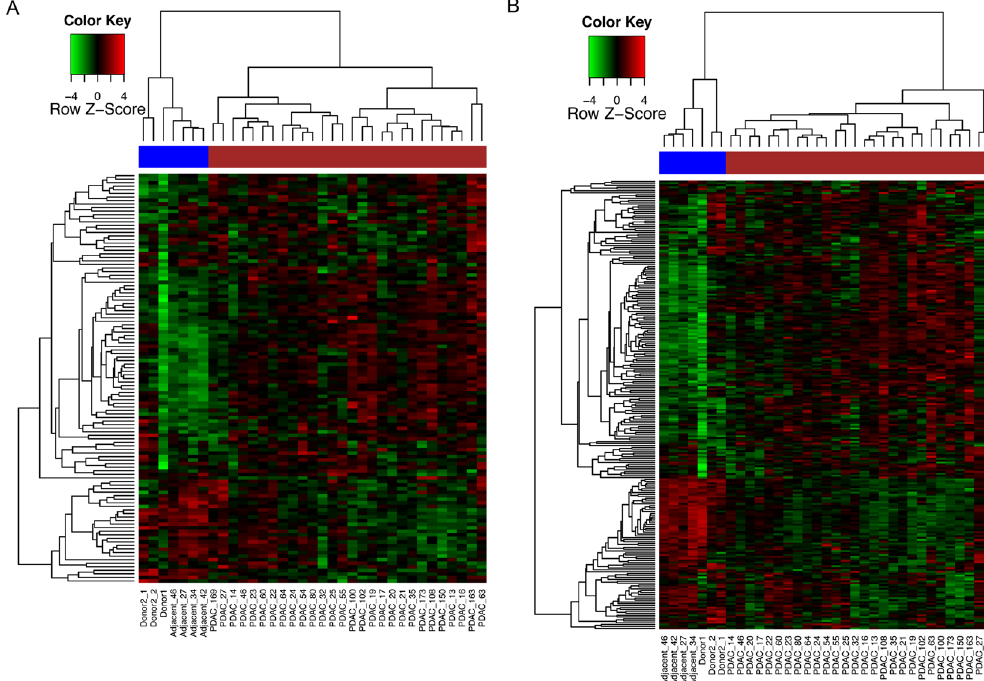
Figure 6. Heatmap showing the expression profiles of 119 ( A ) and 238 ( B ) spliceosomal genes, with the upregulated genes shown in red and downregulated in green. PDAC samples were indicated with the brown bar, while normal samples were indicated with the blue